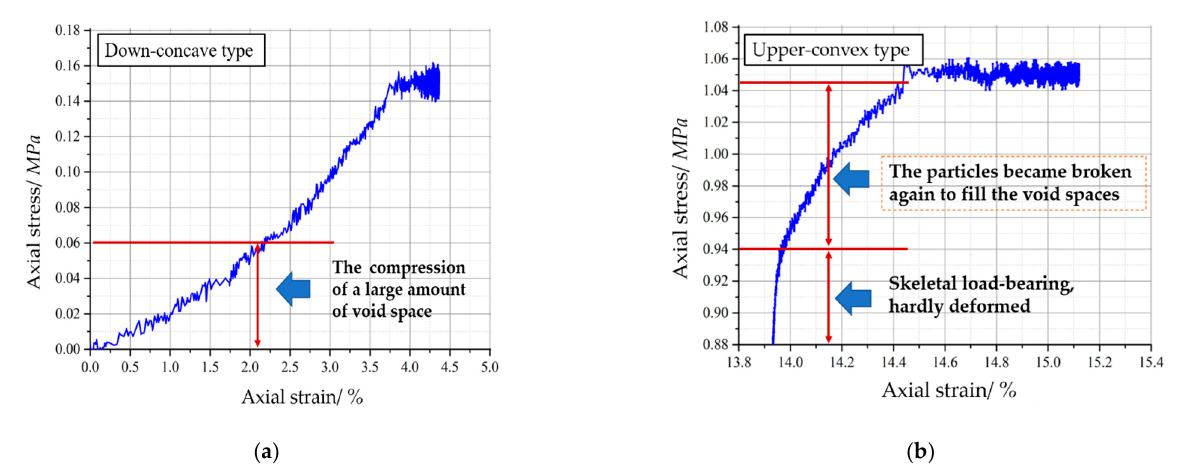
Figure 14. The deformation mechanism of two types of stress-strain curves: ( a ) down-concave type; ( b ) upper-convex type.